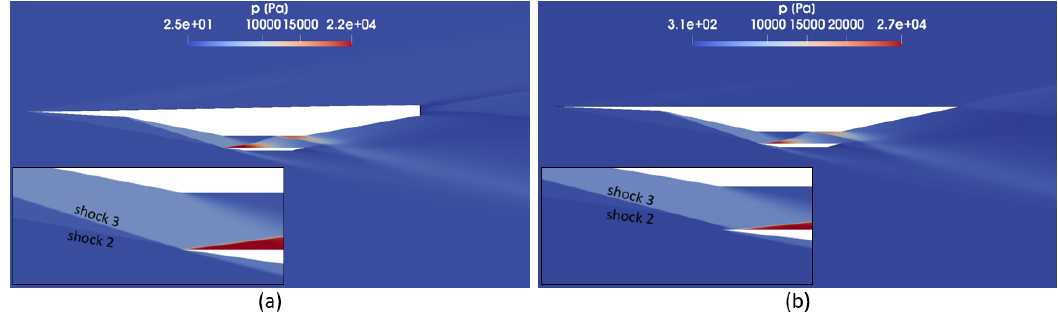
Figure 15. Pressure field of case 2 ( a ) and case 3 ( b ) for AoA = 0 ◦